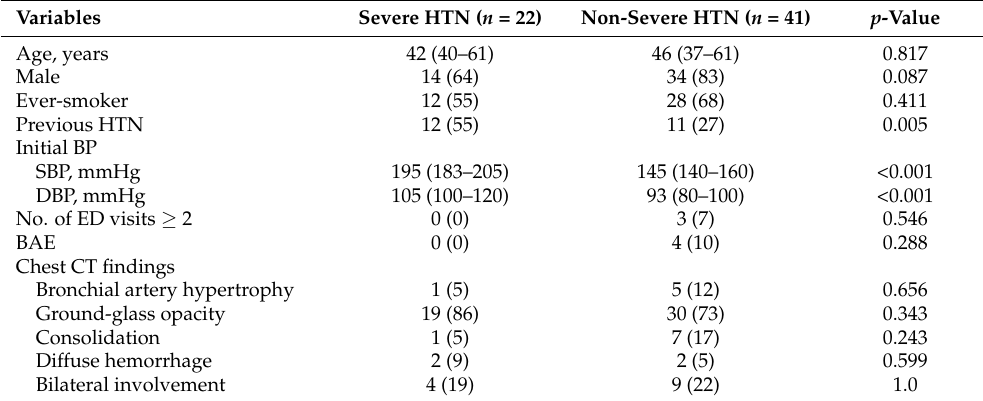
Table 4. Clinical and radiologic characteristics of patients with hemoptysis of unidentified causes according to the presence or absence of severe